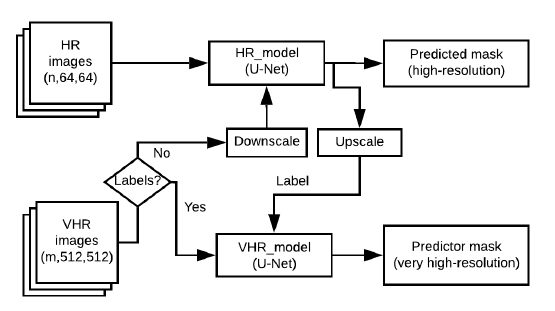
Figure 1. Knowledge transfer based on two models, which uses mapping information from lesser resolution images to improve the segmentation capability of the very high-resolution images. pixels, from which 945 have binary labels, considering 1 for pixels representing water areas, and 0 otherwise; and the re- maining 168 patches correspond to unlabeled images.